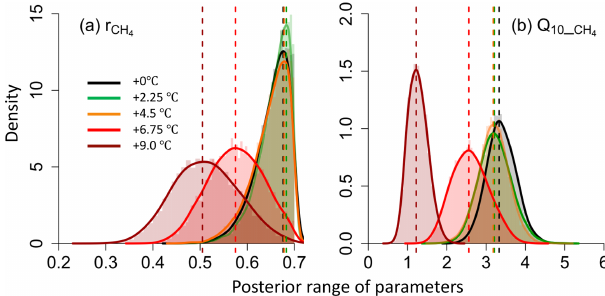
Figure 5. Posterior distribution of the ratio of CH 4 : CO 2 (a) and the temperature sensitivity of methane production ( Q 10_CH five warming